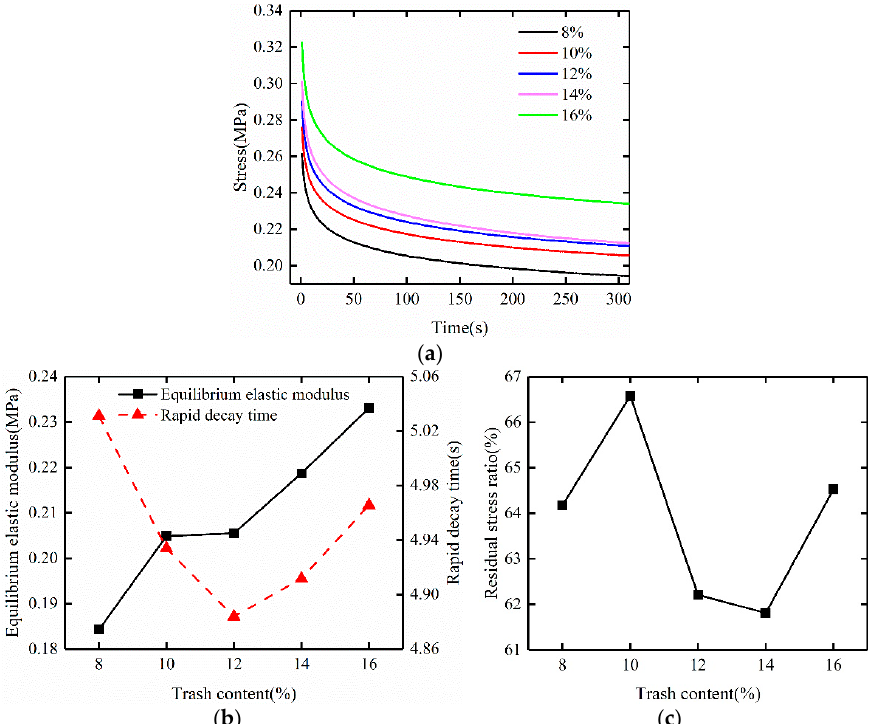
Figure 5. Stress relaxation characteristics at different trash contents: ( a ) Stress relaxation curve; ( b ) Equilibrium elastic modulus E e and rapid decay time T 1 ; ( c ) Residual stress ratio ε .